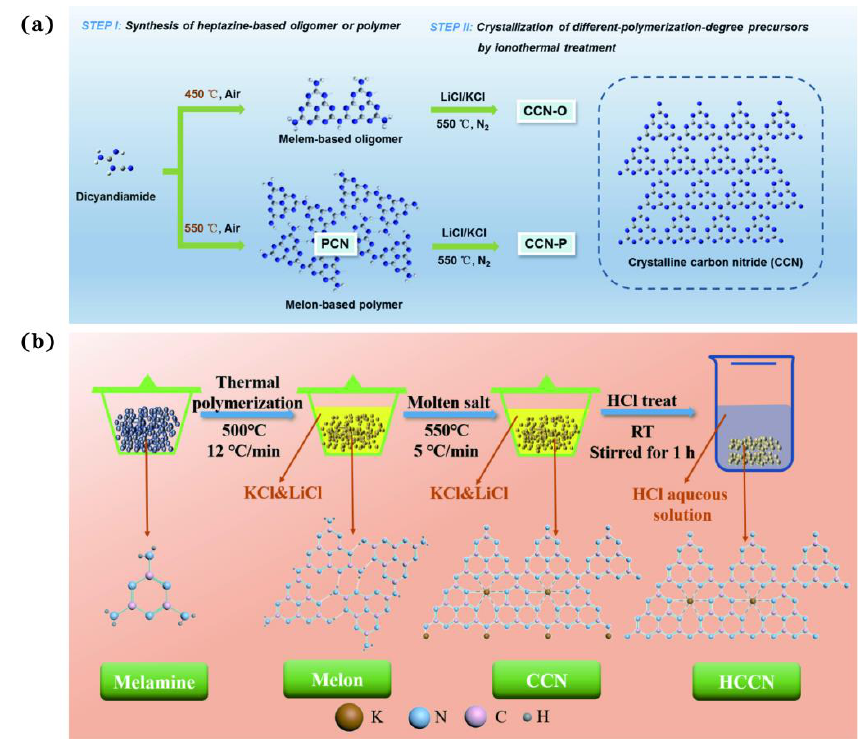
Figure 12. ( a ) Schematic illustration for the crystallization process of g − C 3 N 4 [114]. Copyright 2020, Elsevier. ( b ) Schematic illustration for improving the crystallinity of g − C 3 N 4 using hydrochloric acid treatment [115]. Copyright 2020, Elsevier.